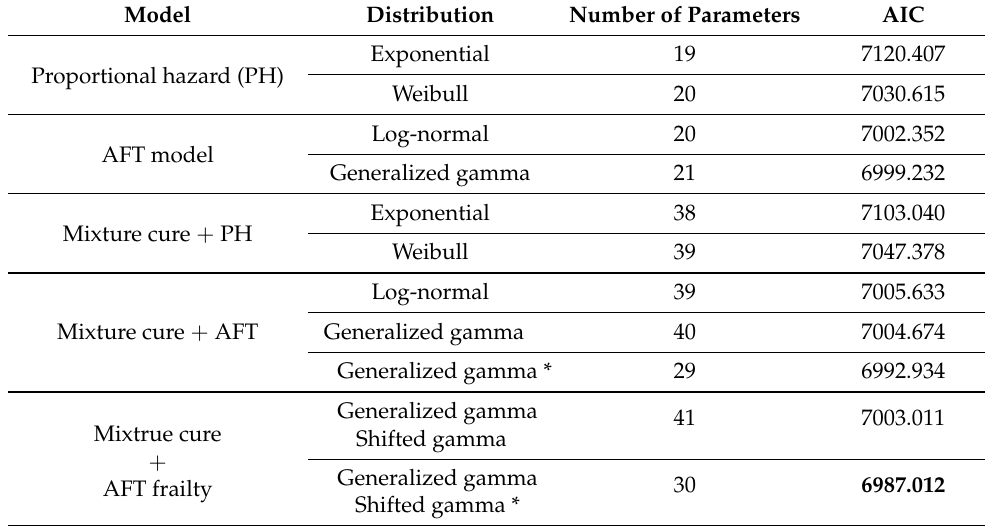
Table 4. AIC for the regression model of the onset of hypertension in males. The asterisk (*) represents that variable selection is performed for the uncured probability p ( Z ) .